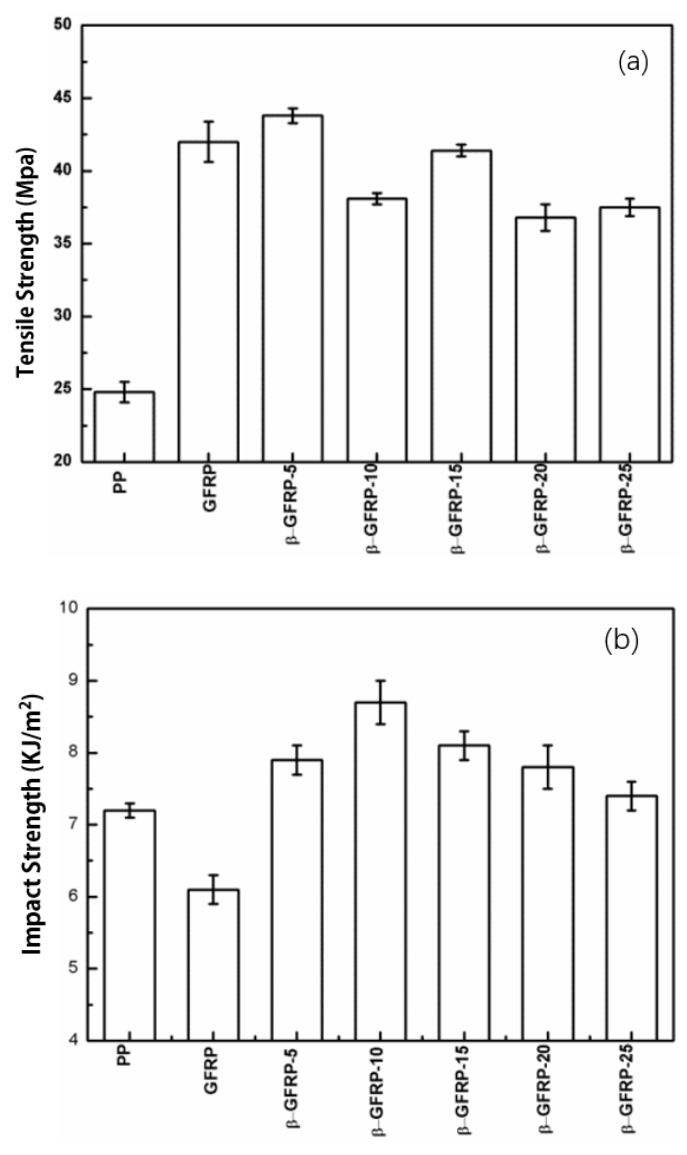
Figure 9. Mechanical properties of β -GFRP: ( a ) Tensile strength; ( b ) impact strength.